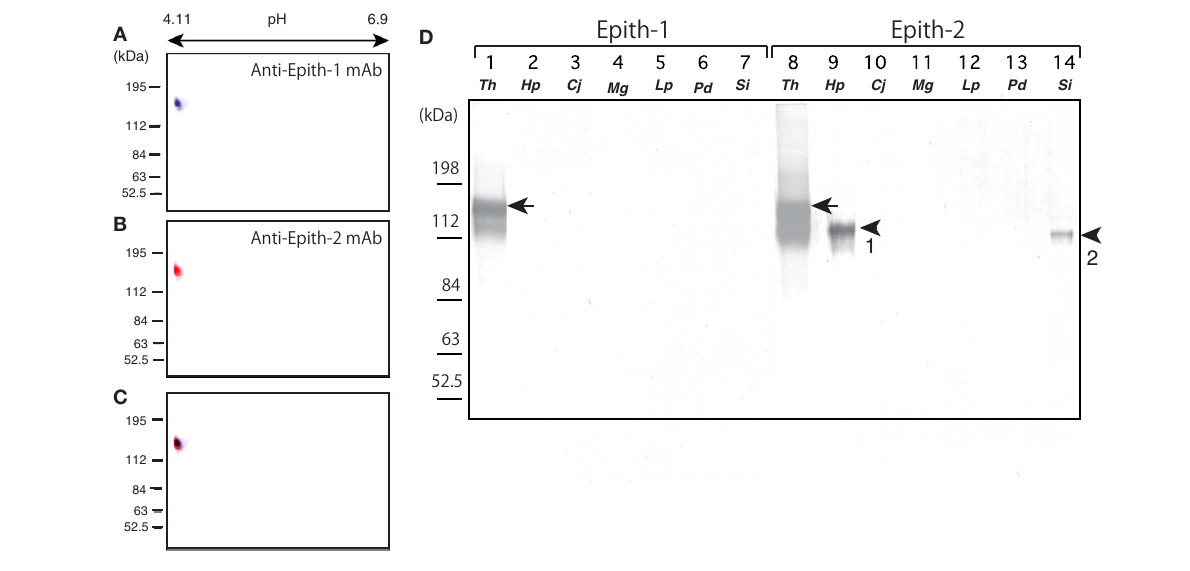
artificially colored. (C) Merged image between (A,B) . (D) Immunocrossreactivity of anti-Epith-1 mAb (lanes 1–7) and anti-Epith-2 mAb (lanes 8–14). Lanes 1, 8; T. hardwicki ( Th ) swimming blastulae, lanes 2, 9; H. pulcherrimus ( Hp ) swimming blastulae, lanes 3, 10; C. japonicus ( Cj ) swimming blastulae, lanes 4, 11; M. globules ( Mg ) swimming blastulae, lanes 5, 12; L. pictus ( Lp ) swimming blastulae, lanes 6, 13; P. depressus ( Pd ) gastrulae, lanes 7, 14; S. intermedius mesenchyme blastulae ( Si ). Arrows, 160kDa region. Arrowhead-1, 143kDa region. Arrowhead-2, 137kDa